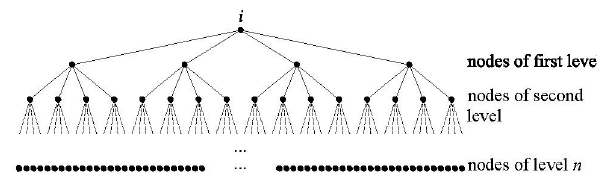
Figure 47: Connections between several levels of the node-to-node